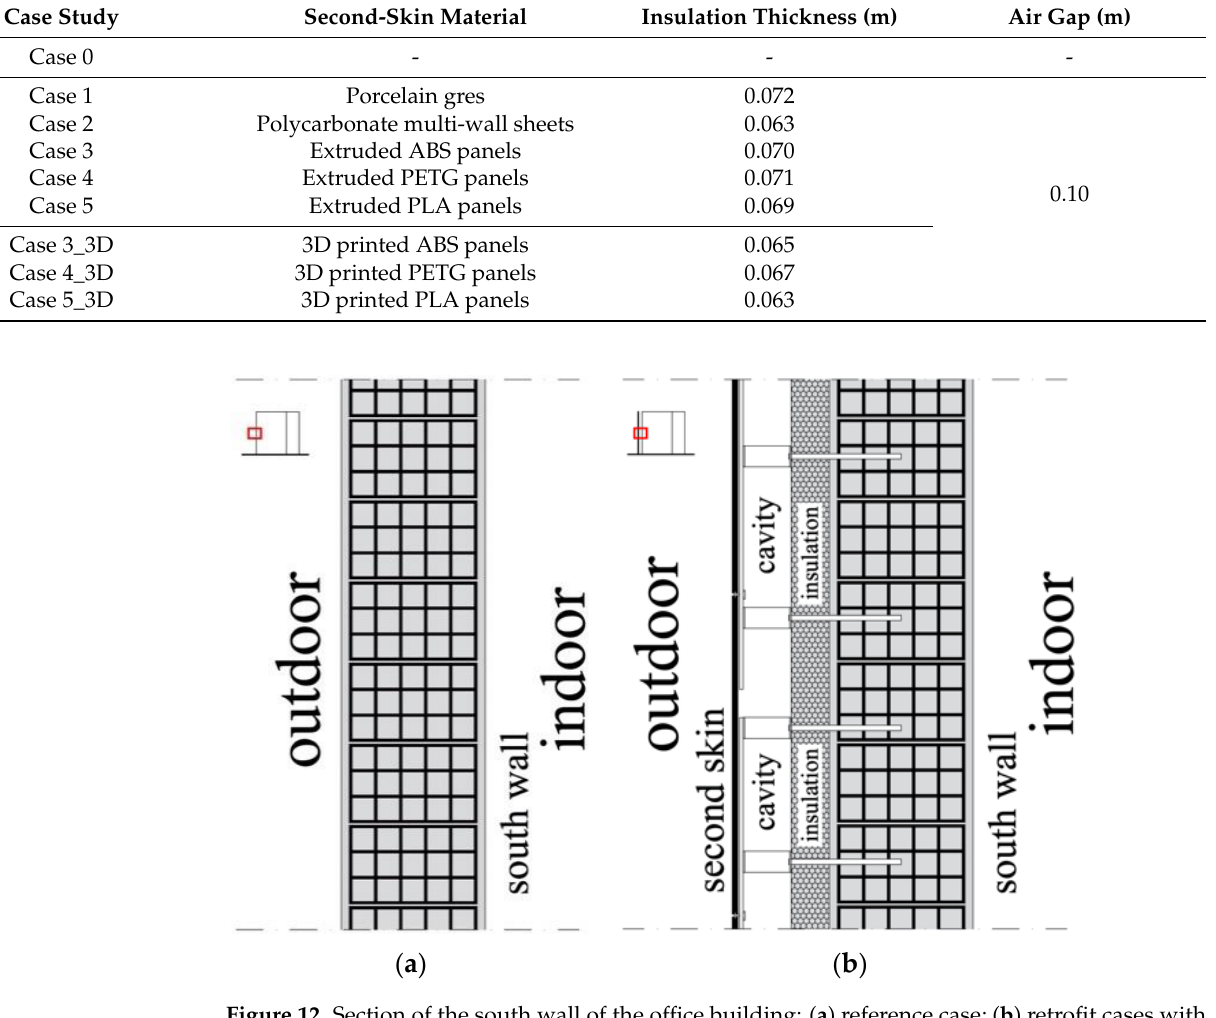
Figure 12. Section of the south wall of the office building: ( a ) reference case; ( b ) retrofit cases with the second-skin system.